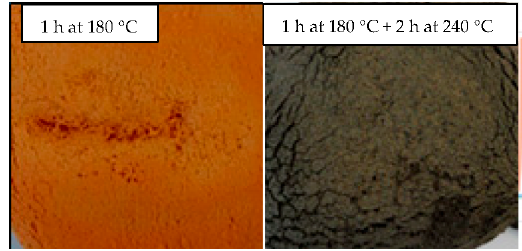
Figure 21. Pictures of samples cured without a post-cure ( left ) and with a post-cure ( right ) at 240 °C.